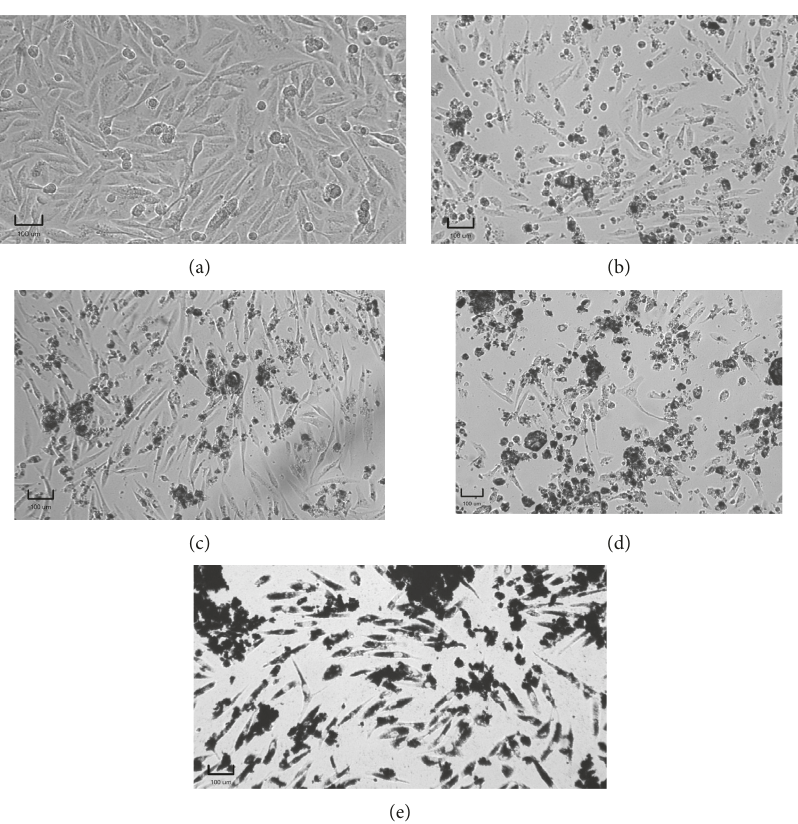
Figure 4: Morphology of A549 cells with different ash concentrations: (a) cells; (b) cells with 80 µ g/cm 3 ; (c) cells with 320 µ g/cm 3 ; (d) cells with 1280 µ g/cm 3 ; (e) cells with titanium oxide (TiO 2 , positive control). Images are representative of all samples. Scale: 100 μ m.